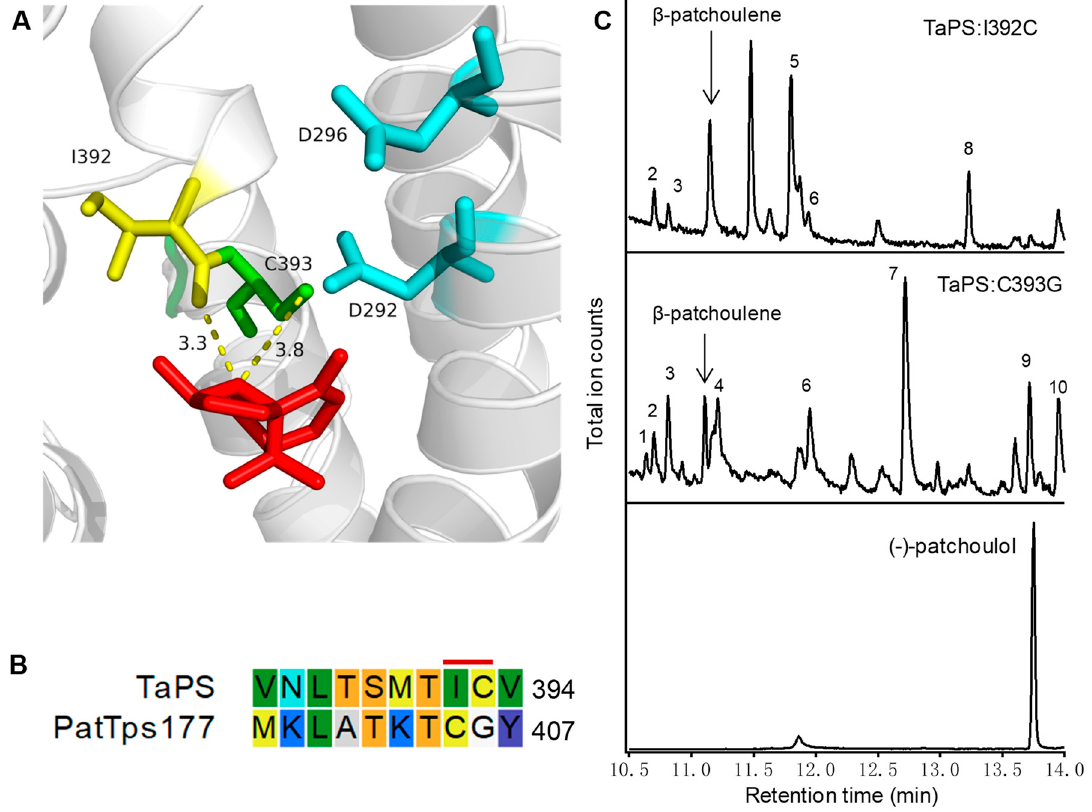
Figure 5. Homology modeling of TaPS and site-directed mutagenesis analysis. ( A ) Catalytic cavity of TaPS was predicted based on homology modeling with docking of the final product β -patchoulene (red). Two key aspartates in the conserved DDXXD motif of terpene synthases were shown in blue. The two unique residues in TaPS, I392 and C393 were shown in yellow and green, respectively. The predicted distances between I392 or C393 and C2 of β -patchoulene were labeled as well (3.3 Å and 3.8 Å, respectively); ( B ) amino acid alignment of TaPS and patchoulol synthase (PatTPS177). The unique I392 and C393 were indicated by the red line. The full alignment was shown in Figure S4; ( C ) GC-MS chromatograms of TaPS:I392C and C393G with FPP as the substrate. The new products were labeled as peak 1–10 and their mass spectra were listed in Figure S5. The authentic ( − )-patchoulol was injected for comparison.